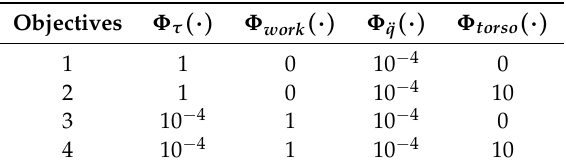
Table 2. Combination of objective functions. Minimization of torques and joint accelerations is always included with small weighting factors to ensure smooth